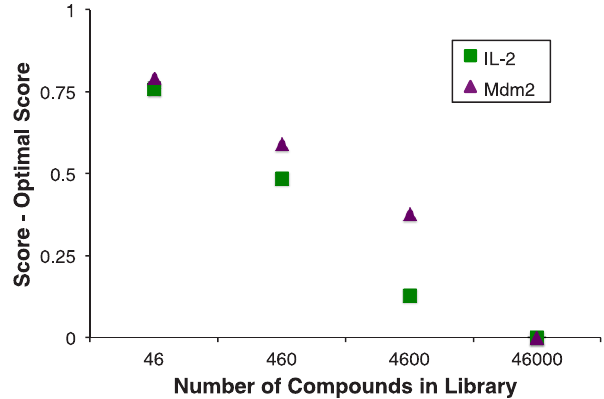
Figure 8. The GPU-enabled speedup facilitates screening of larger libraries, which in turn allows better-scoring ligands to be identified. Compound libraries of increasing size were screened against interleukin-2 and Mdm2. As expected, screening larger libraries led to identification of compounds with better scores. All scores are reported relative to the lowest scoring ligand in the largest set.